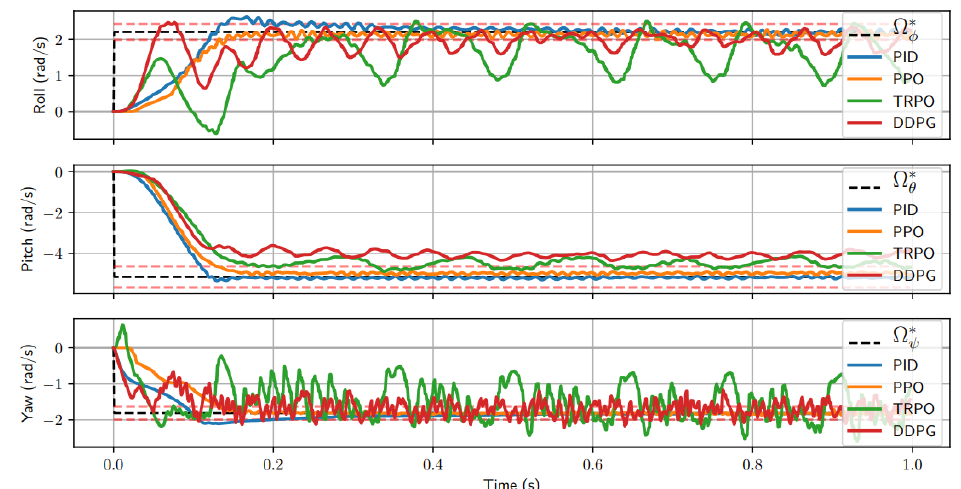
Figure 7. Step response of best trained RL agents compared to PID. Target angular velocity is